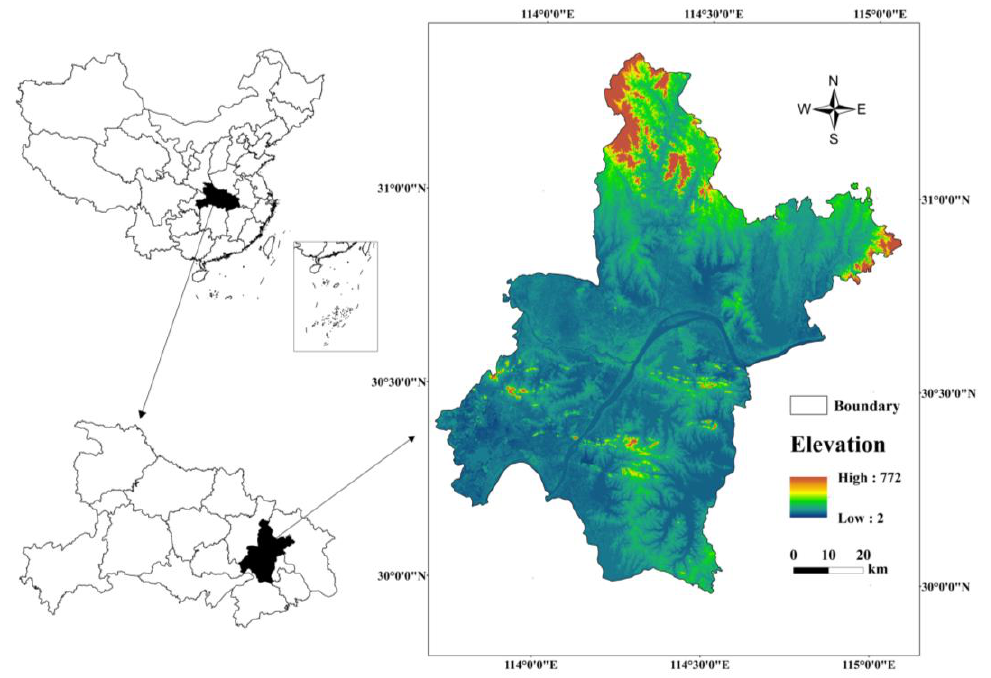
Figure 1. Location and topography of the study area.